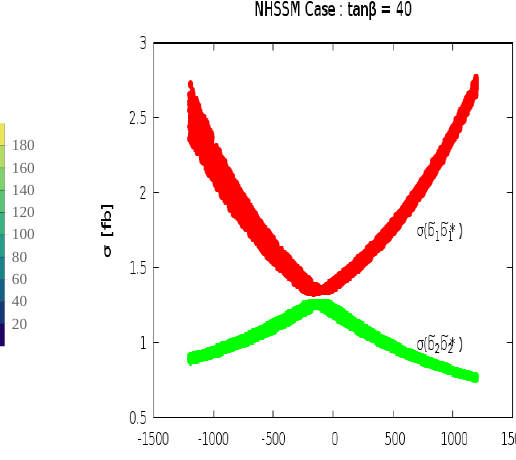
in the A 0 {tan (cid:12) plane (left) and variations of (cid:27) ( pp b b 2 ; ~ b 1 ) for tan (cid:12) = 40 and 100 GeV (cid:22) 350 GeV. For both plots m ~ b (cid:20) (cid:20)